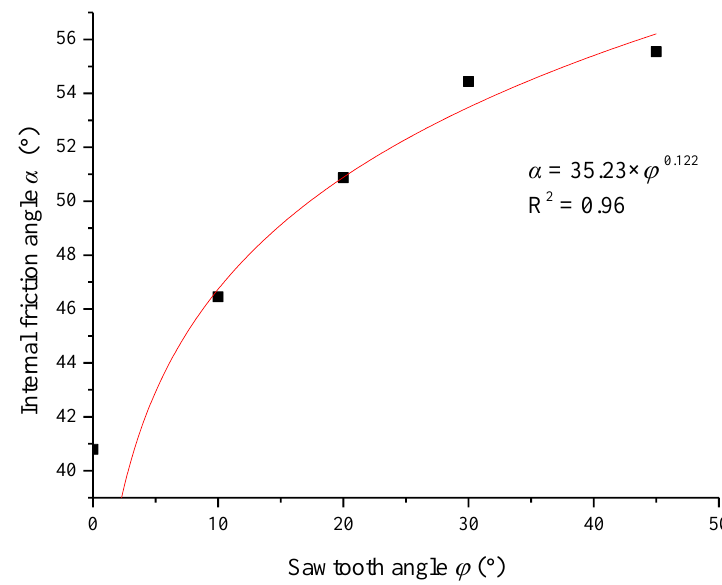
Figure 6. Relationship between internal friction angle and sawtooth angle.